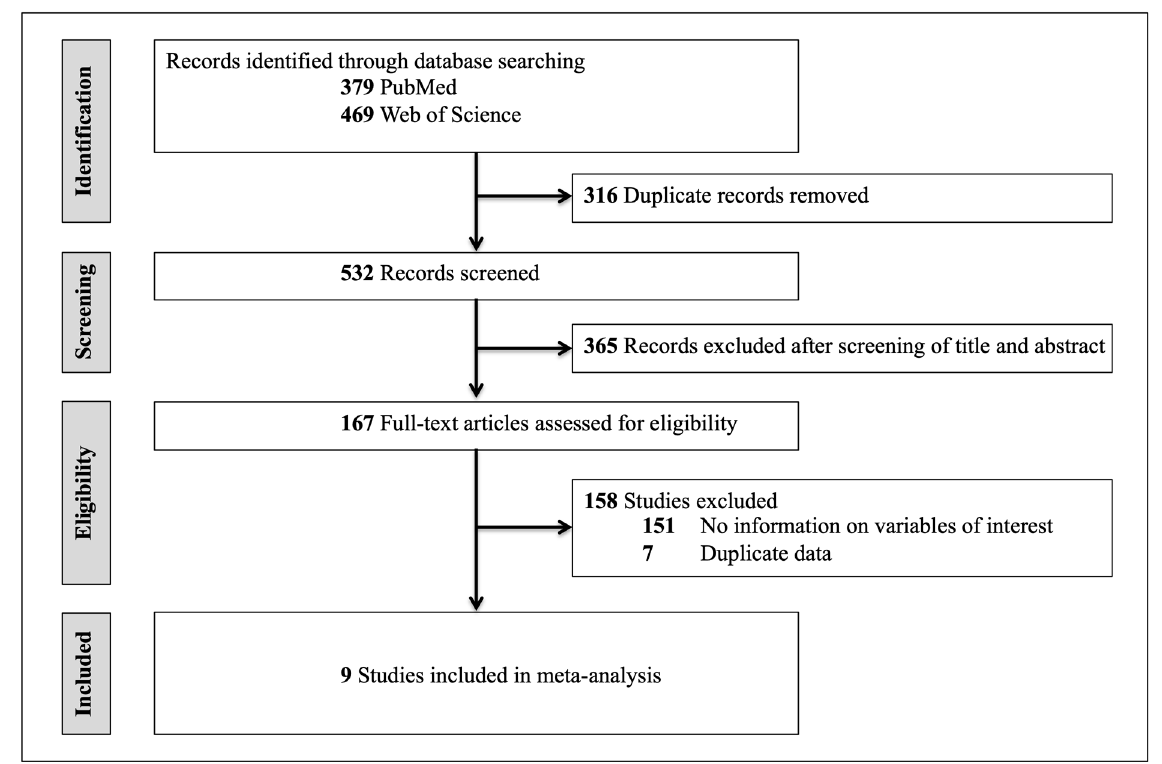
Figure 1. Flowchart of study selection.